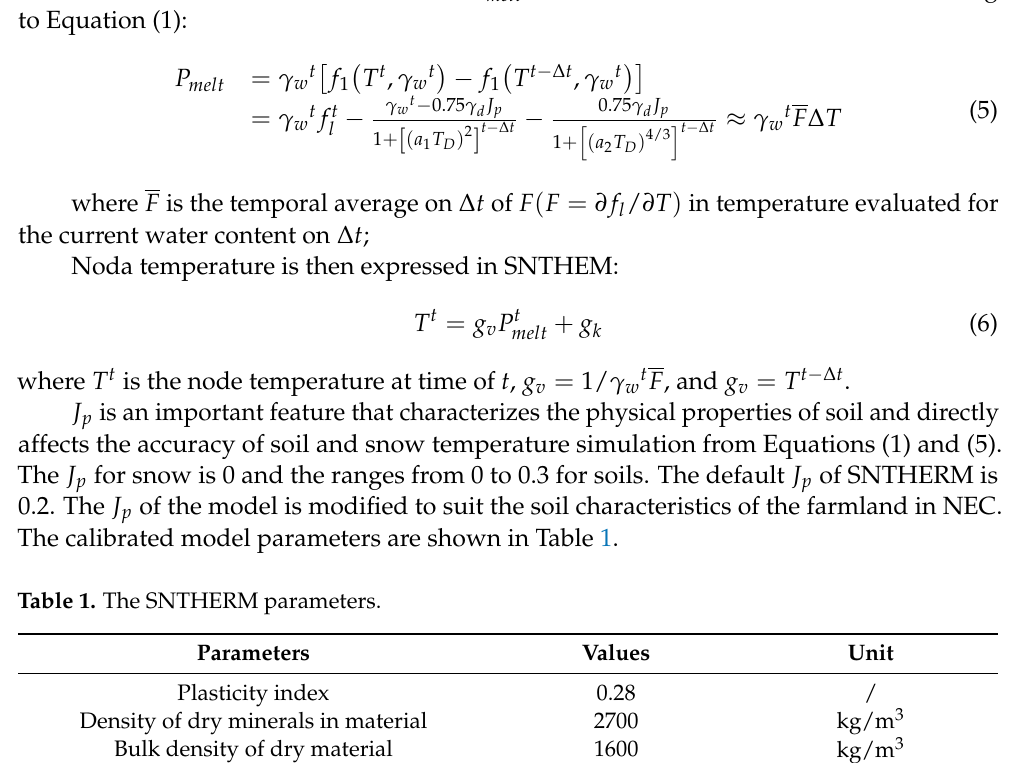
Table 1. The SNTHERM parameters. Parameters Values Unit Plasticity index 0.28 / Density of dry minerals in material 2700 kg/m 3 Bulk density of dry material 1600 kg/m 3 Heat capacity of dry material 800 J/kg · K Thermal conductivity for dry bulk material 0.113 W/m · K Snow albedo 0.78 / Irreducible water saturation for snow 0.04